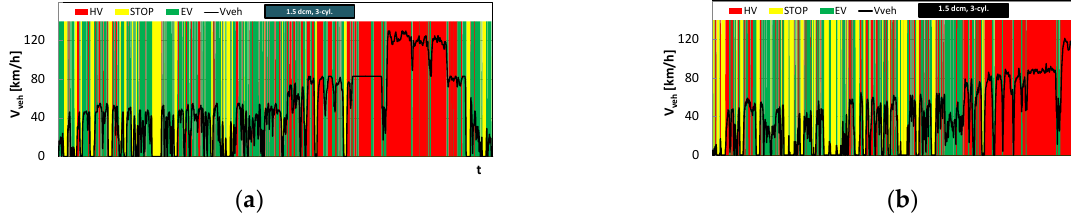
Figure 1. Test route with the powertrain operating conditions: ( a ) newer solution with the 3-cylinder engine; ( b ) older solution with the 4-cylinder engine.